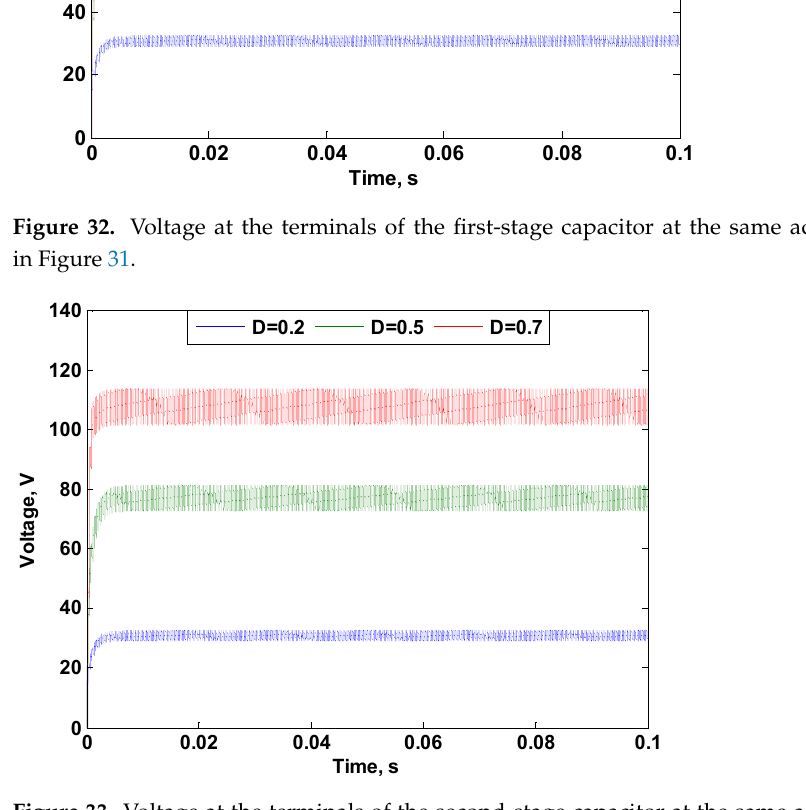
Figure 33. Voltage at the terminals of the second-stage capacitor at the same adopted duty ratios in Figure 31.